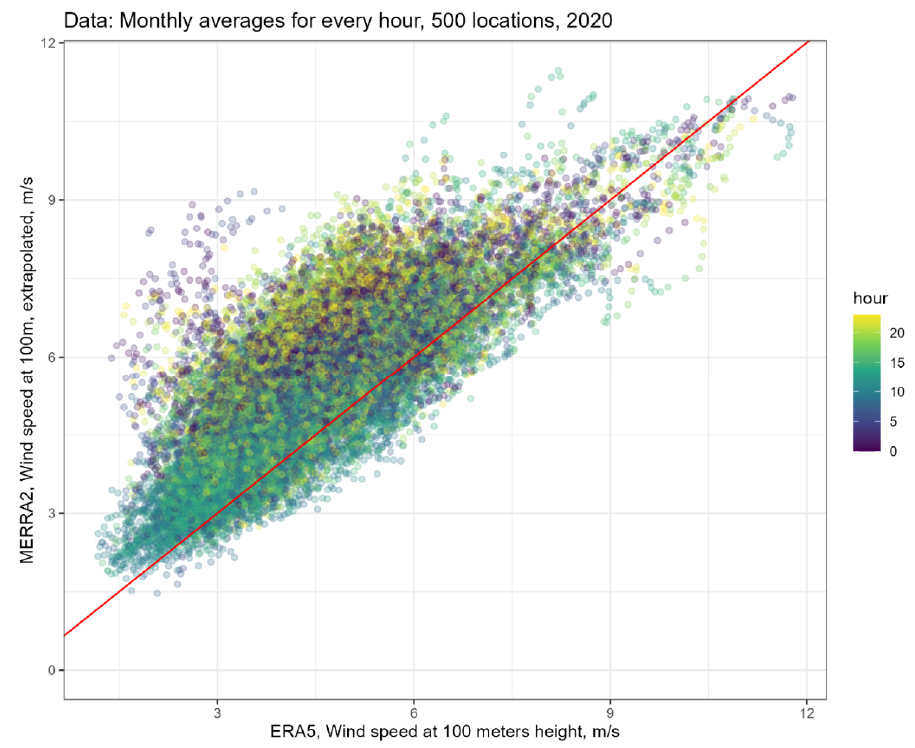
Figure A7. Comparison of monthly average wind speed at 100 m height in ERA5 and MERRA-2 (extrapolated from 10 and 50 m heights) datasets.